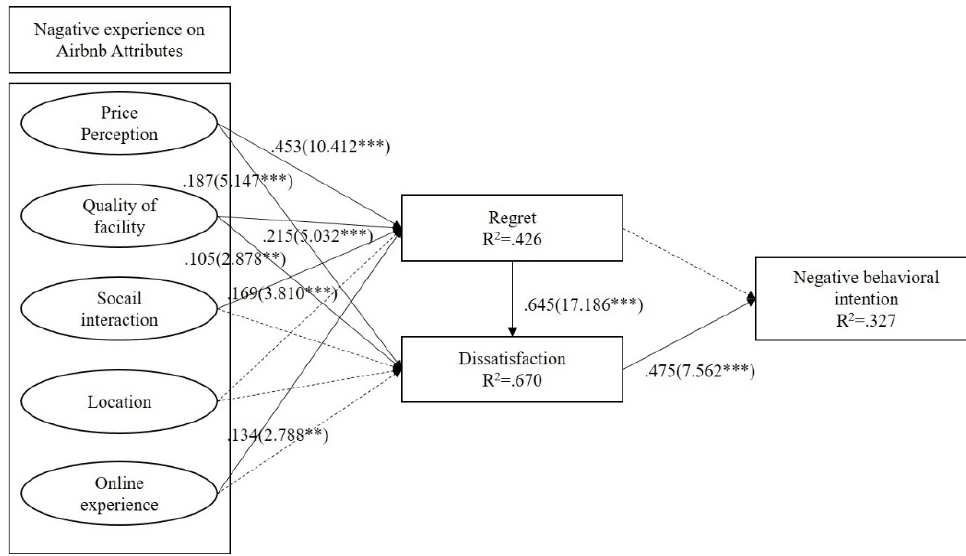
Figure 2. The Result of the Structural Model. Note. *** p < 0.001, ** p < 0.01. Table 5. Structural parameter